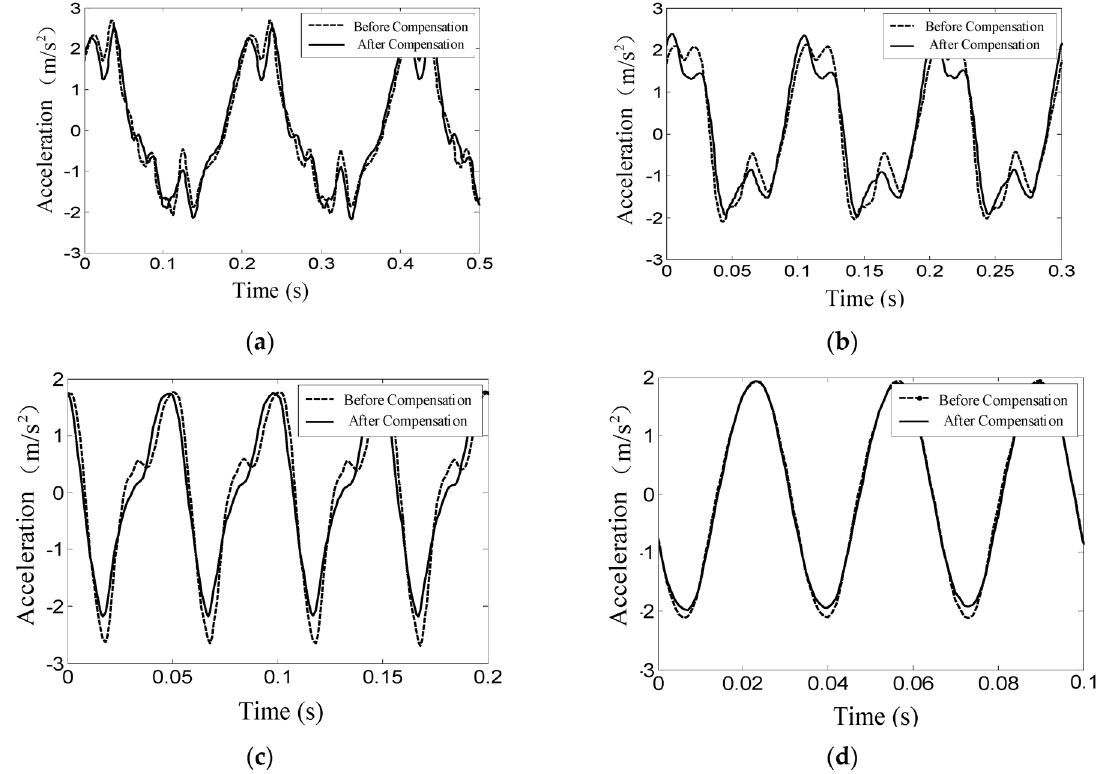
Figure 8. Effect of nonlinear compensation control: ( a ) 5 Hz, ( b ) 10 Hz, ( c ) 20 Hz, ( d ) 30